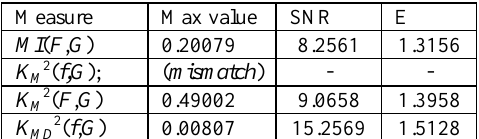
Table 2 Numeric data for TV-IR matching (Example 2).